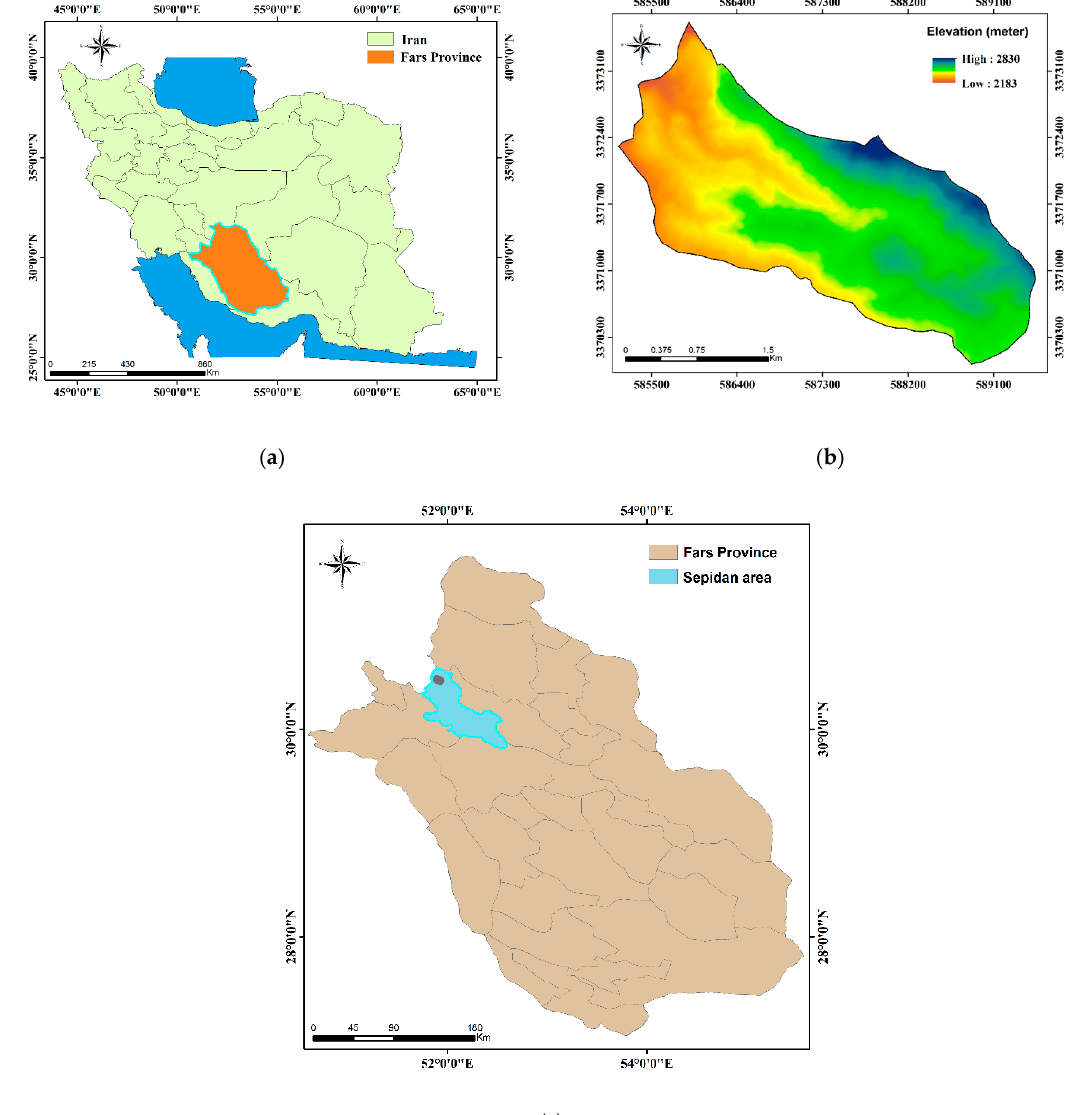
Figure 1. Location map of the study area. Fars province in Iran ( a ), Sepidan Area in Fars province ( b ), habitat basin and DEM ( c ).